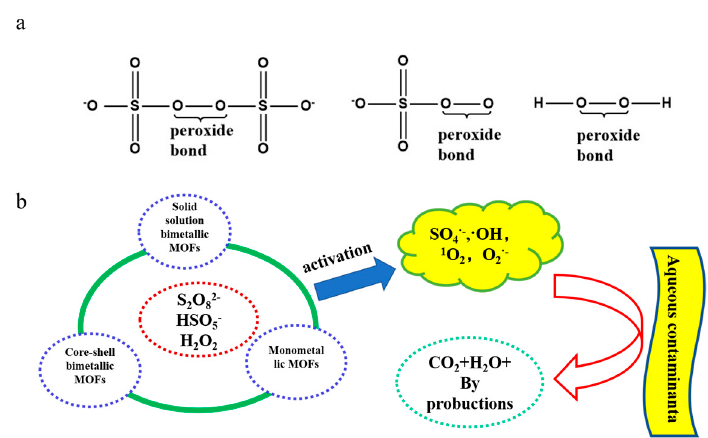
Figure 6. ( a ) Molecular structure of PDS, PMS, and H 2 O 2 ; ( b ) Schematic diagram of the MOF activation PDS, PMS, and H 2 O 2 process. Adapted with permission from Ref. [67], 2023, Elsevier. Table 1. Activation of MOF materials by di ff erent peroxides.